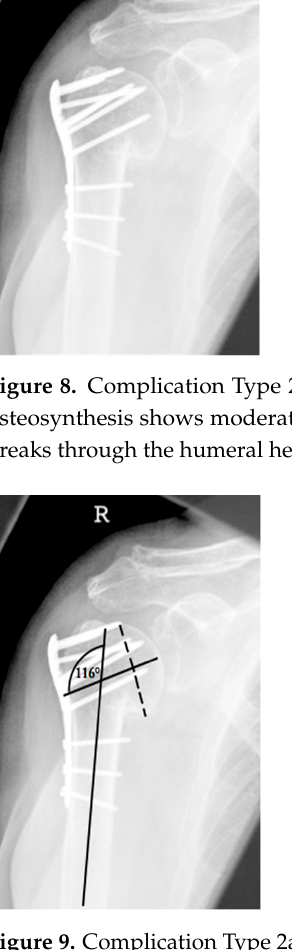
Figure 10. Complication Type 2a. Pa tt ern image. Moderate grade varus displacement of the humeral head after angular stable plate osteosynthesis is illustrated by the transition of the dashed drawing (initially correct humeral head position) to the prominent black drawing with screw cutout (double). Complication Type 2b Complication Type 2b is limited to displacement of the greater tuberosity, the lesser tuberosity, or both tuberosities (Figure 11, 12).